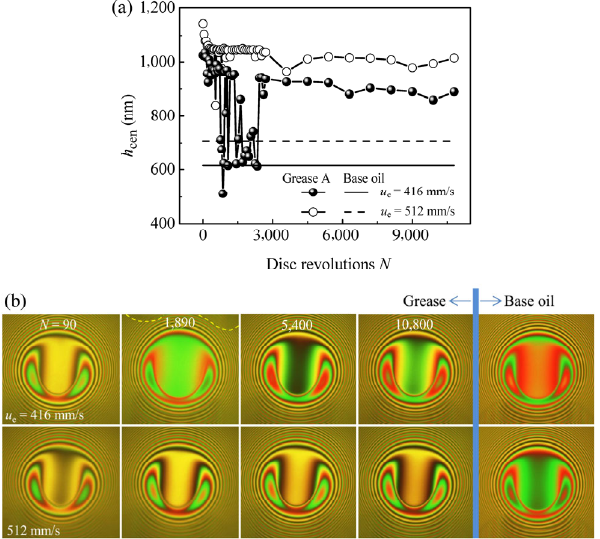
Fig. 6 Evolutions of EHL films against disc revolutions under elevated speeds, Grease A. (a) Variations of film thickness with disc revolutions; (b) interference